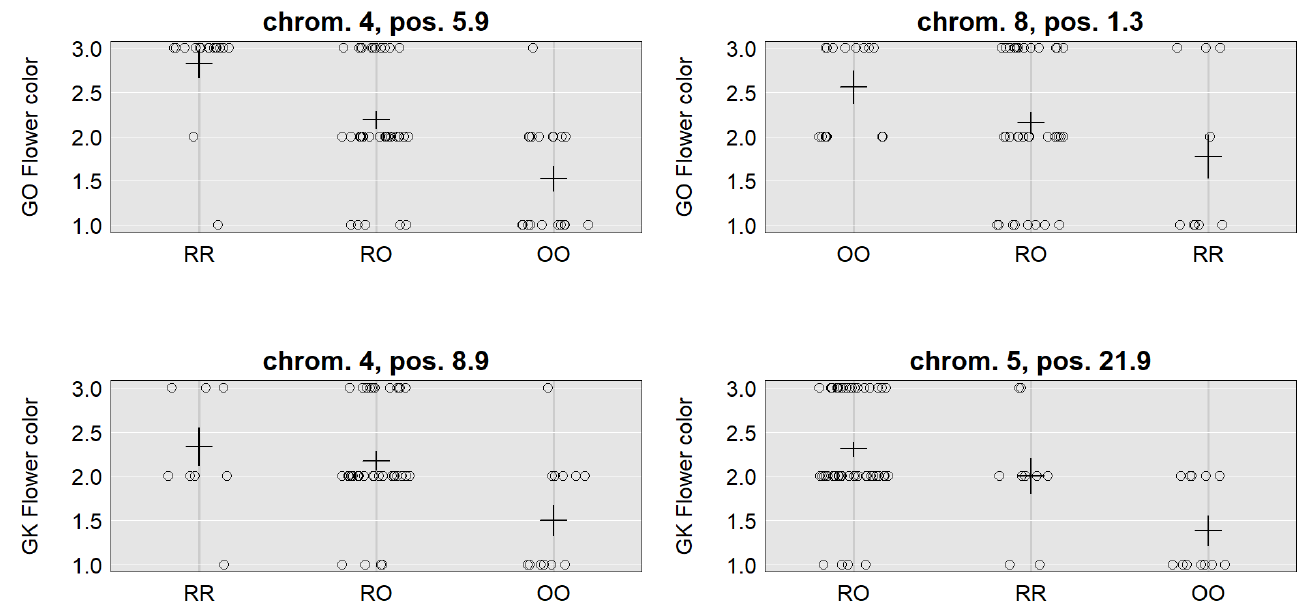
Figure 6. Flower color phenotypes by genotype at the QTLs identified in the Gokce × Oyali-084 (GO) and Gokce × Karab-092 (GK) mapping populations. The x -axis shows genotypes made up of cultivated reference (R) or wild other (O) alleles. The y -axis shows phenotypes scored ordinally as cultivar-like white (1), wild-like purple (3), or a mix of colors (2). Circles are per individual measures. Crosses are the mean and standard error per